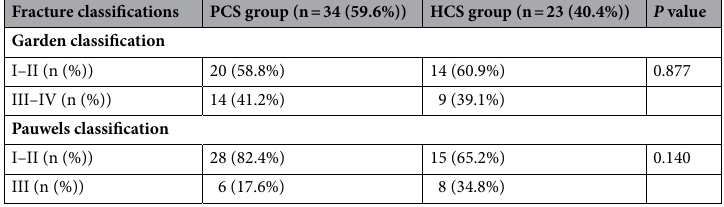
Table 2. Fracture classification of patients in different internal fixation groups.